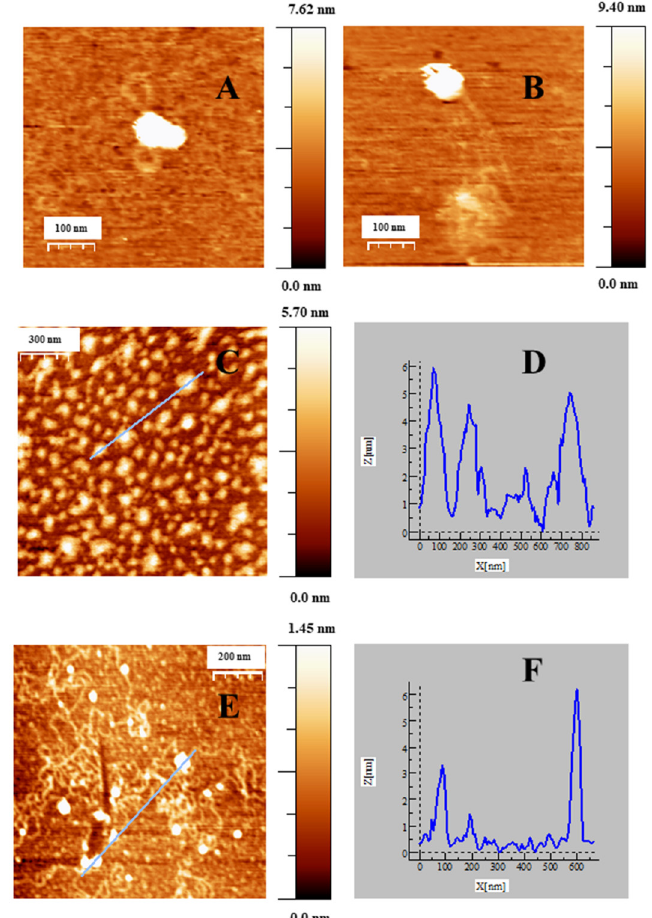
Figure 4. AFM topography images of C I complexes adsorbed on APTES modified mica surface in cacodylate buffer (I = 1.63 mM, pH = 7.4; C DNA = 0.3 μ M, C Doxo = 7.5 nM), under different reaction conditions. ( A , B ) Intermediates of compaction, C Au@16-Ph-16 =1.07 pM; ( C ) C I complexes at a compact stage, C Au@16-Ph-16 = 22.5 pM. ( E ) C I complexes at a decompacted stage, C Au@16-Ph-16 = 124.5 pM. ( D – F ) correspond to the cross section along the selected lines for ( C , E